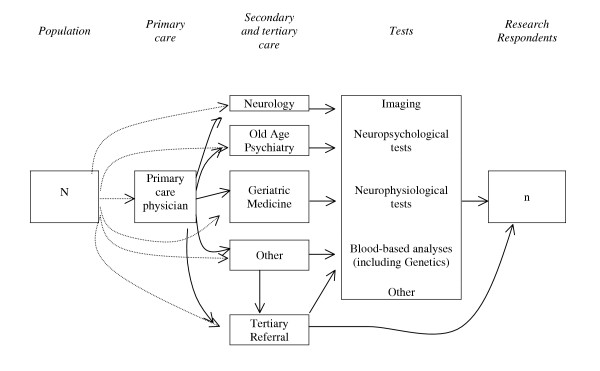
Pathways through which individuals may be filtered before becoming potential research respondents. Note: In systems such as in the UK, referral from secondary and tertiary services is almost always through primary care. This is not the case in all health care systems. N = true population. n = study